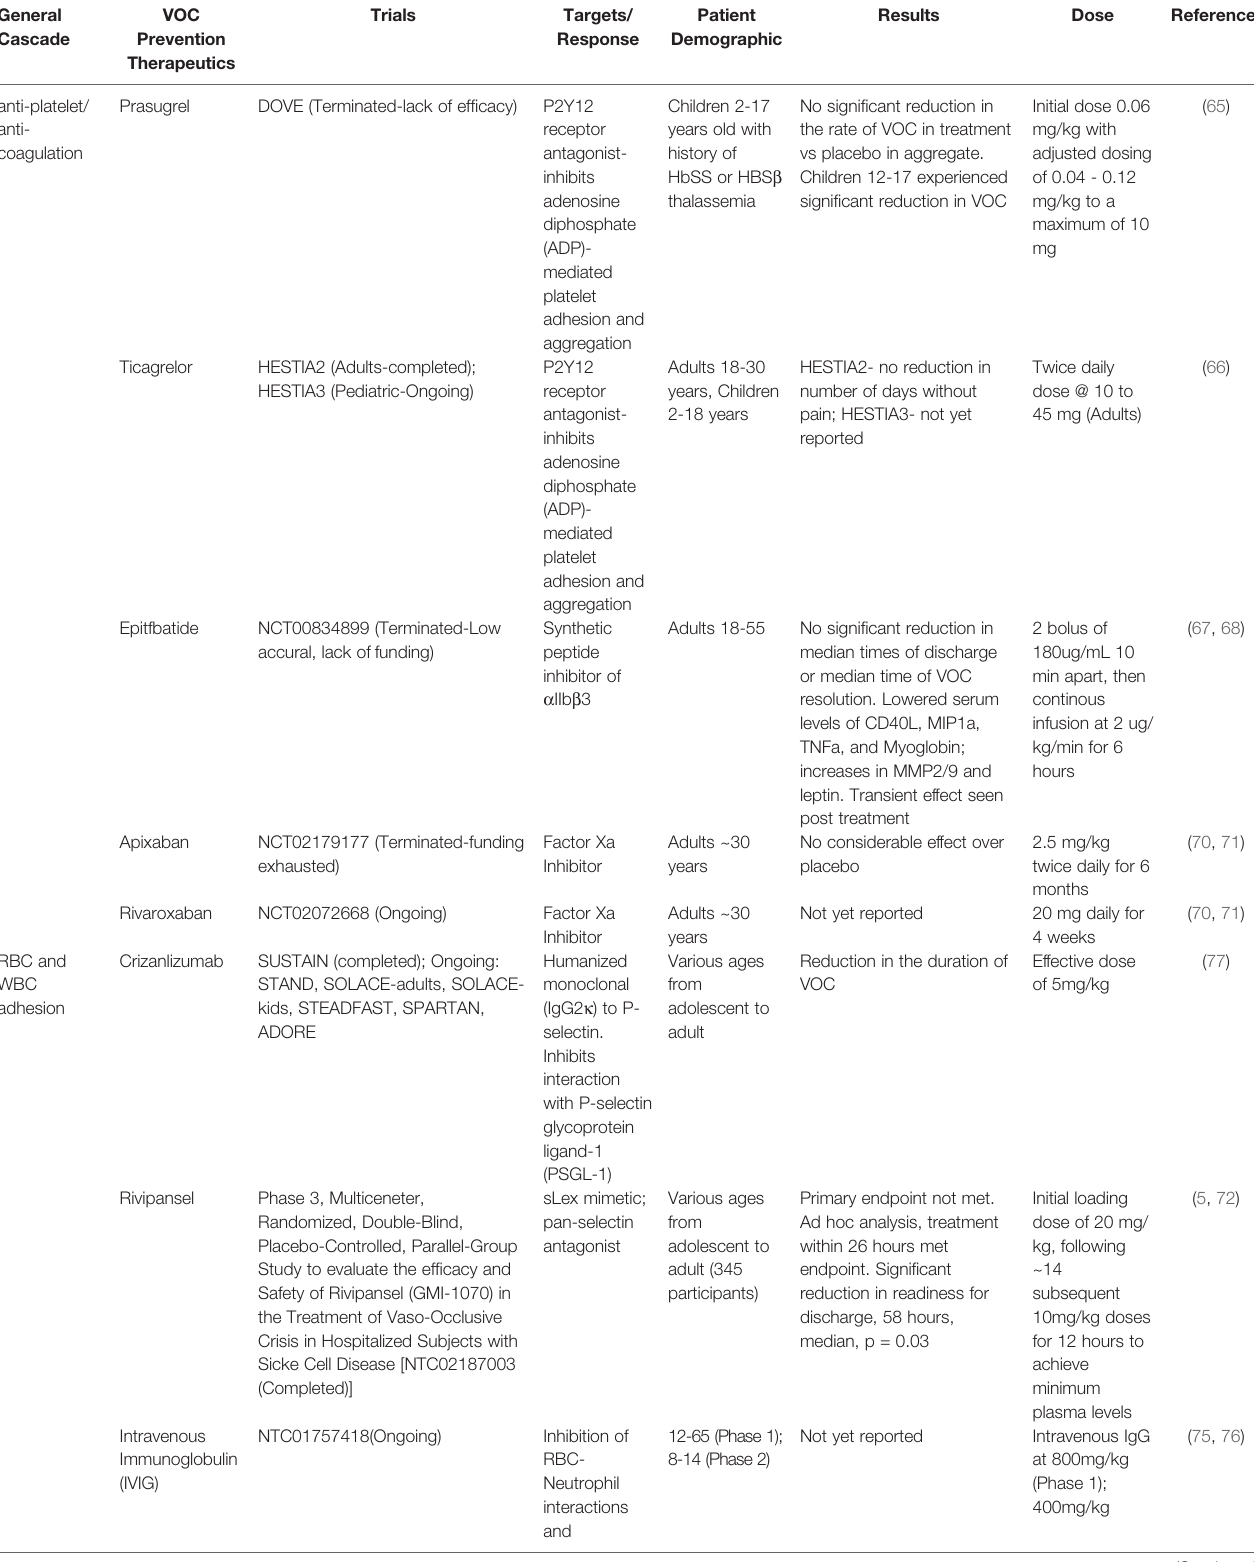
TABLE 2 | Current agents being investigated to treat